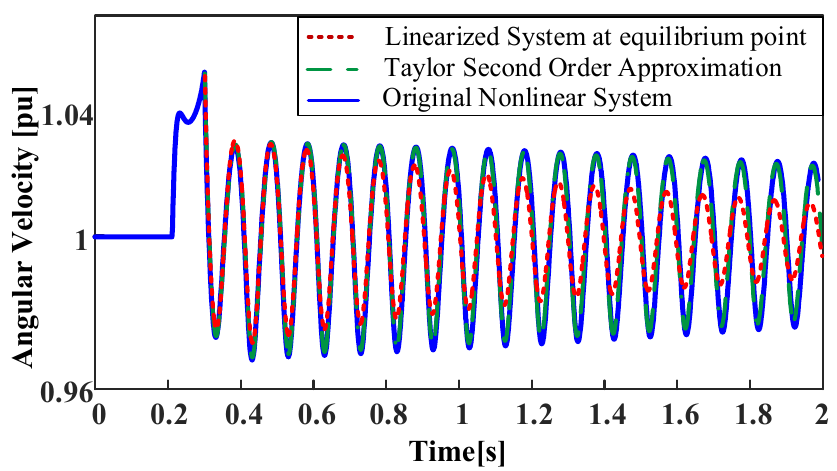
Figure 17. Comparative simulated results among original nonlinear system, first order and second order approximated system at equilibrium point.